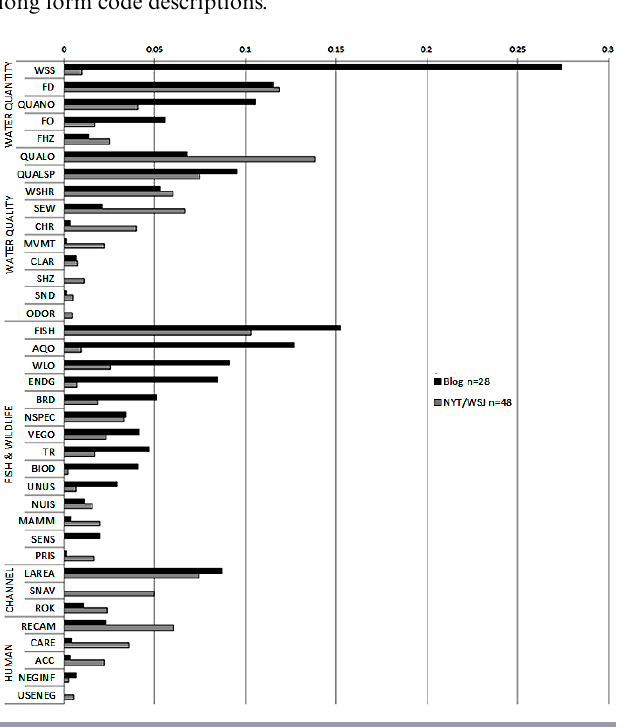
Fig. 1 . Attribute normalized frequencies, see Appendix 1 for long form code descriptions.